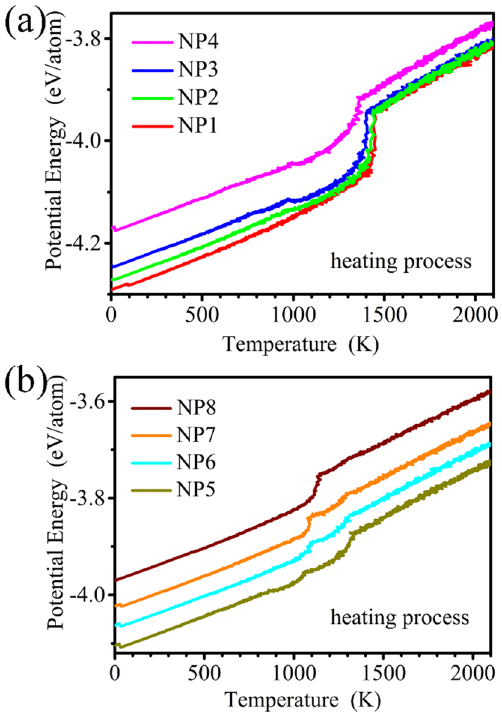
Figure 4. Variation of potential energy as function of temperature for the NPs heating process ( a ) NP1, NP2, NP3, NP4 ( b ) NP5, NP6, NP7,